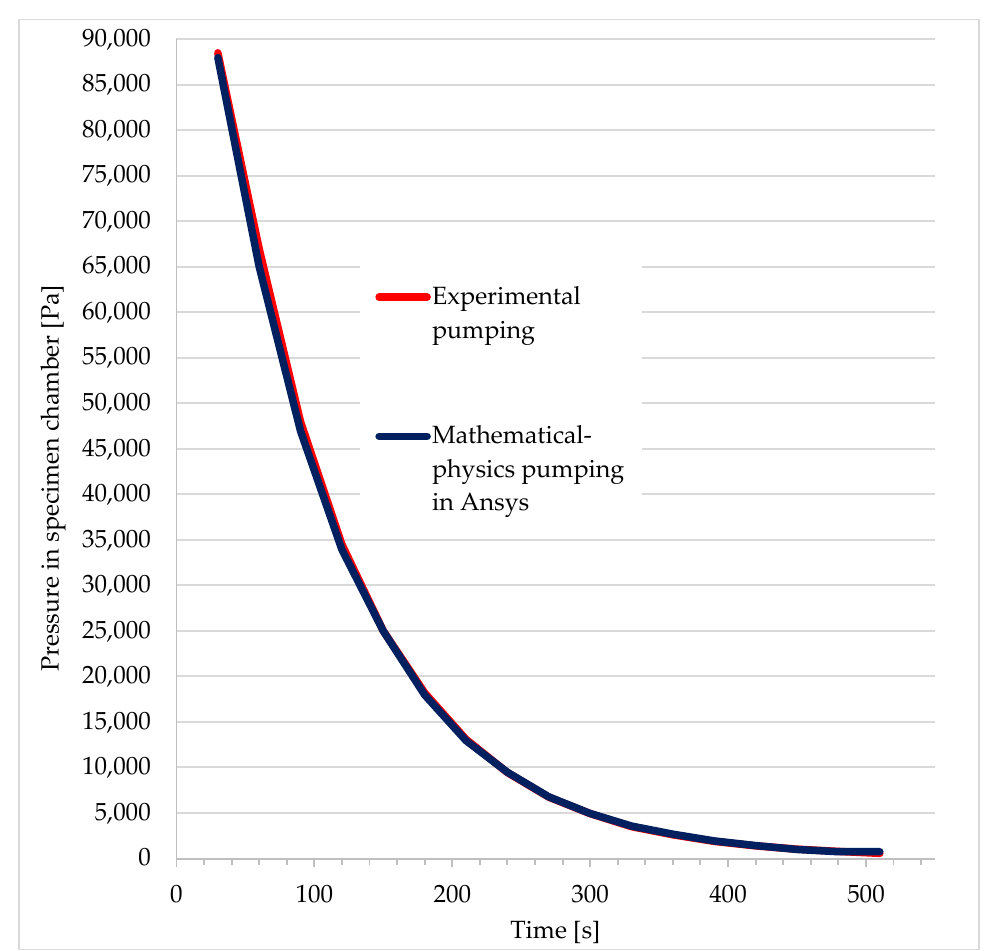
Figure 3. Comparison of experimental results with mathematical and physical analysis.